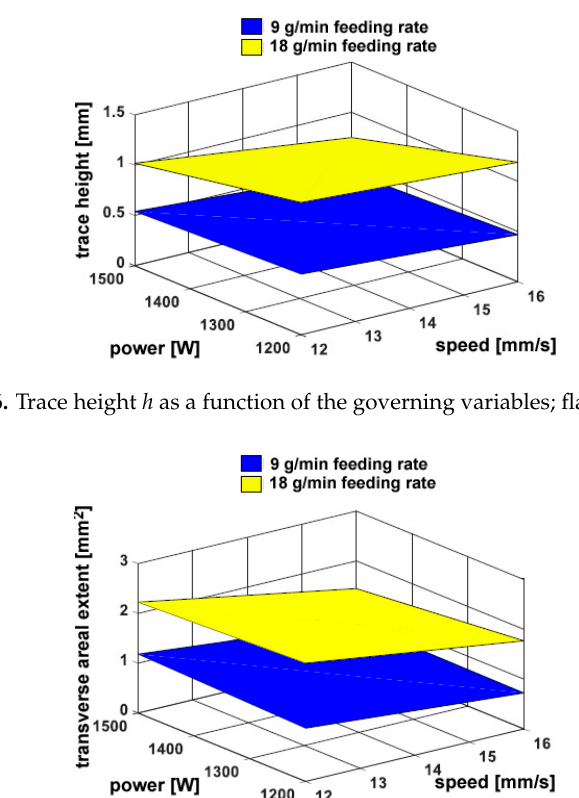
Figure 5. Trace width w as a function of the governing variables; flat deposition.